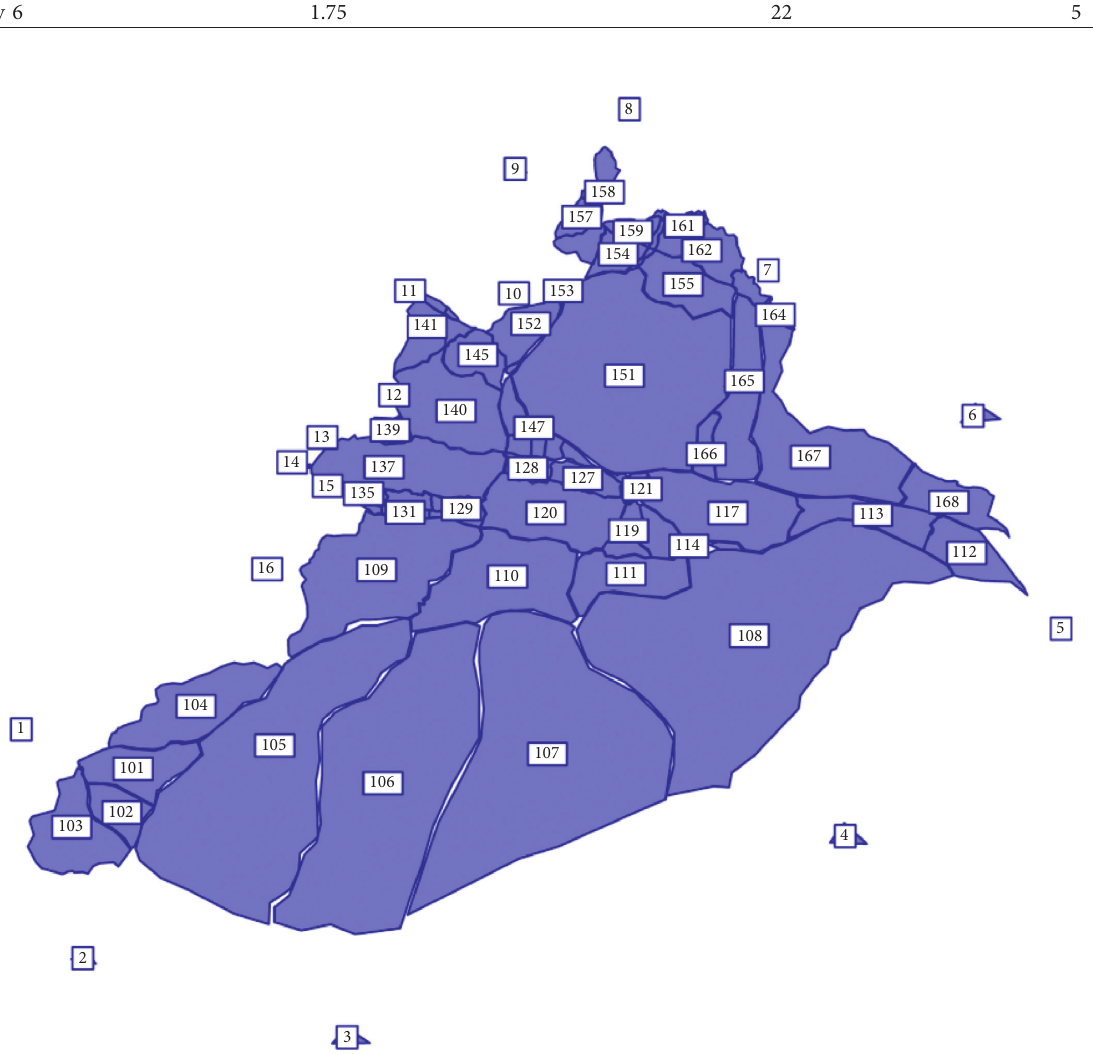
Figure 3: Highway network district division of